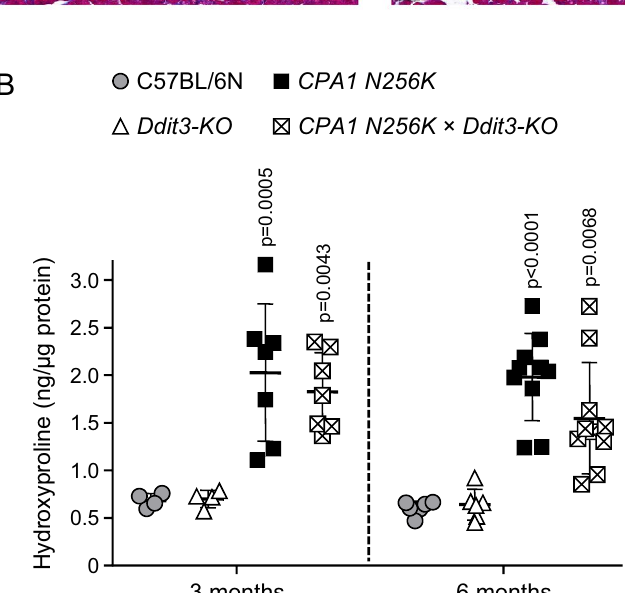
Figure 7. Fibrosis in the pancreas of CPA1 N256K × Ddit3-KO mice. ( A ) Masson’s trichrome staining of pancreas sections from 3-month-old C57BL/6N, Ddit3-KO, CPA1 N256K, and CPA1 N256K × Ddit3-KO mice. Collagen is stained blue. The scale bar corresponds to 50 µm. ( B ) Hydroxyproline content of the pancreas from C57BL/6N (n = 4 and 6), Ddit3-KO (n = 4 and 6), CPA1 N256K (n = 7 and 10), and CPA1 N256K × Ddit3-KO (n = 6 and 10) mice at 3 months and 6 months of age. Individual data points with mean (horizontal bar) and standard deviation are